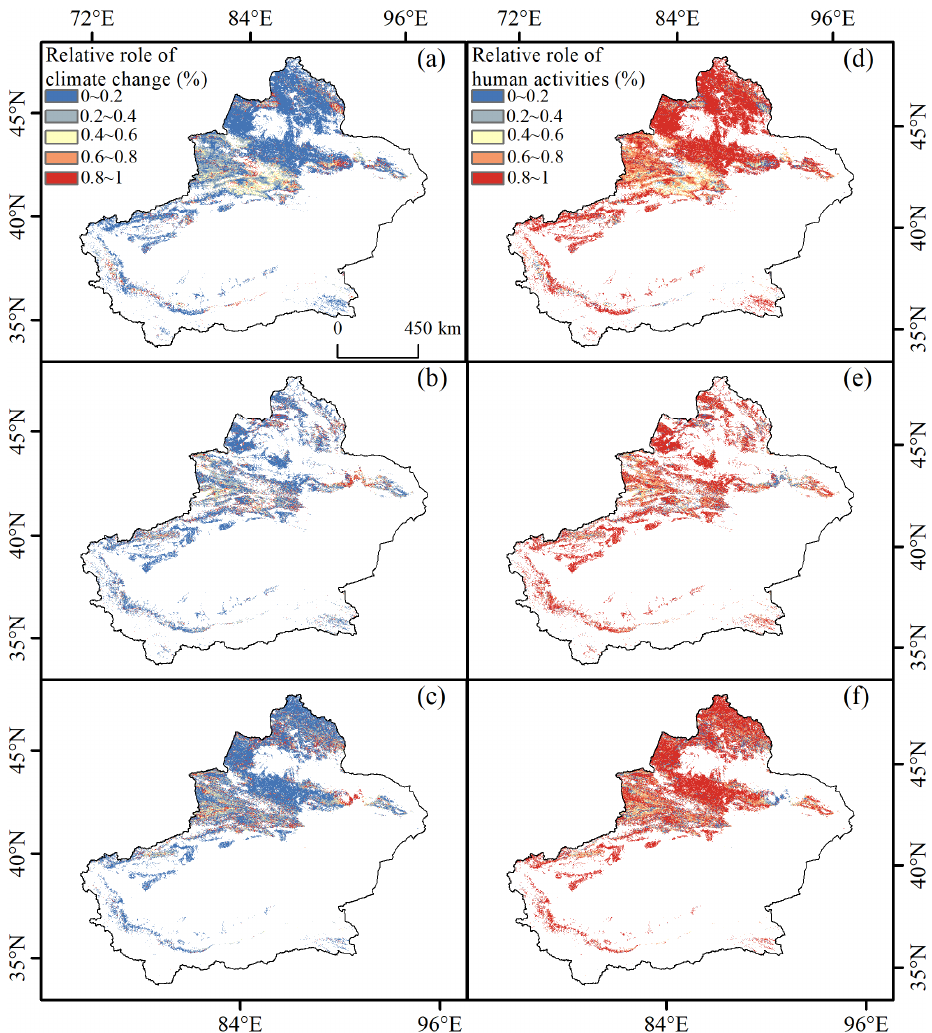
Figure 12. Spatial distribution of the relative role of climate change and human activities on the variation in the ecosystem indicators from 2001 to 2015. ( a ) Relative role of climate change in ET, ( b ) Relative role of climate change in GPP, ( c ) Relative role of climate change in LAI, ( d ) Relative role of human activities in ET, ( e ) Relative role of human activities in GPP, and ( f ) Relative role of human activities in